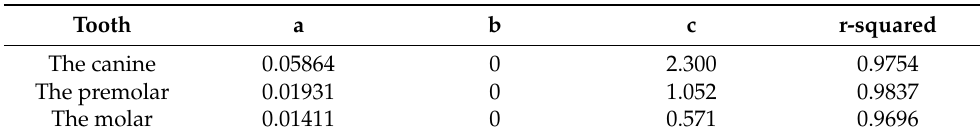
Table 4. Parameters of the quadratic model between the average stress and the penetration depth for different teeth.